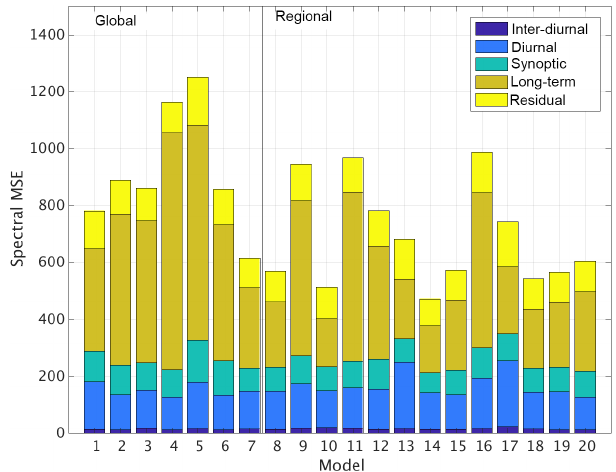
Figure 4. Distribution of the mean square error (MSE) across the models of the two communities and the scales on which the signal has been decomposed (LT, long term; SY, synoptic; DU, diurnal; ID, inter-diurnal; see text for